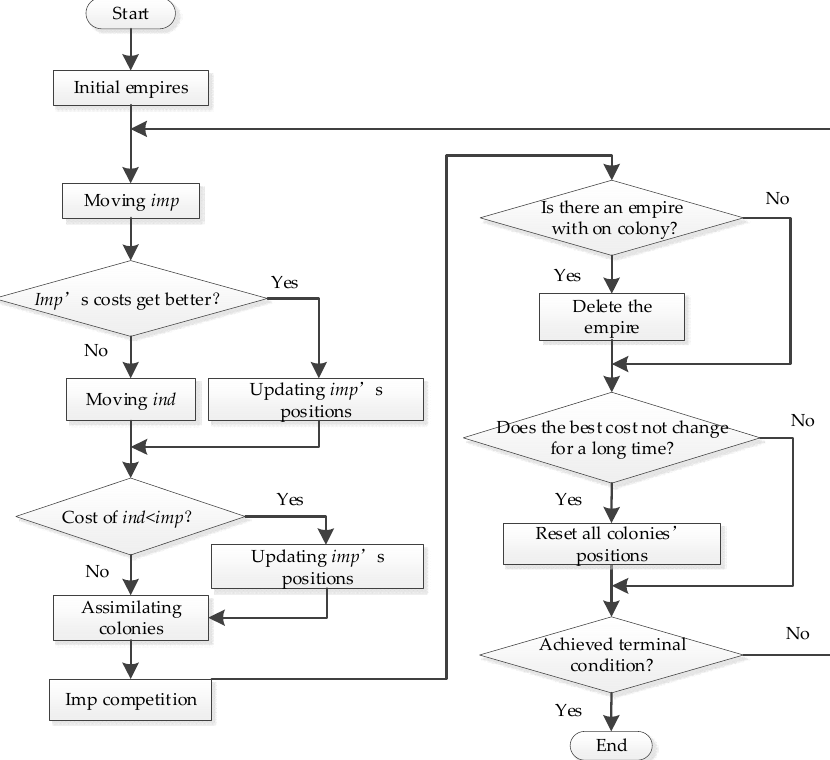
Figure 4. Flow chart of the proposed PSOICA.